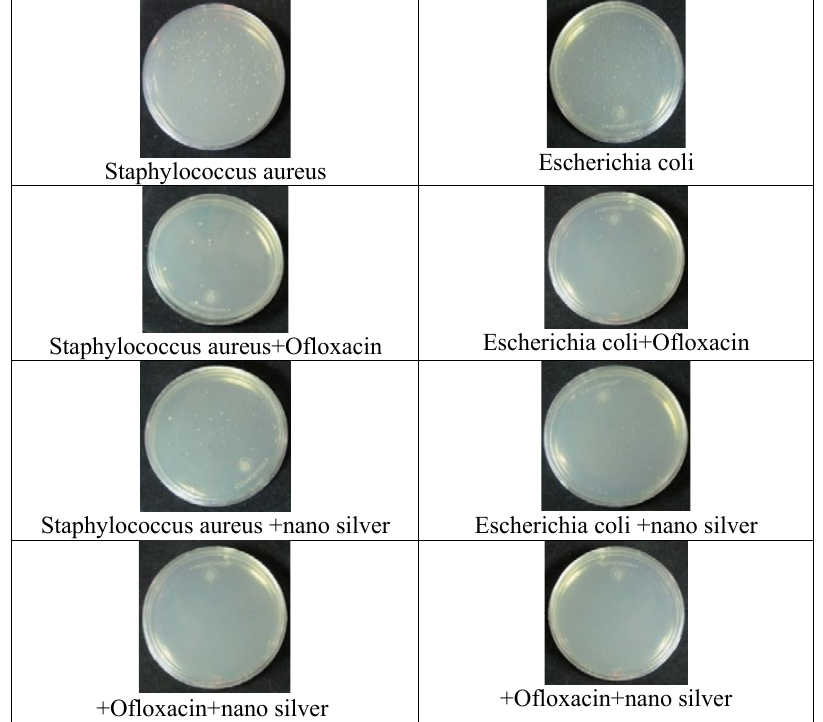
Fig. 5.2: Quantitative test results, Antibacterial assay of sterile gauze coated with Bassorin/PEO on S. aureus and E. Coli